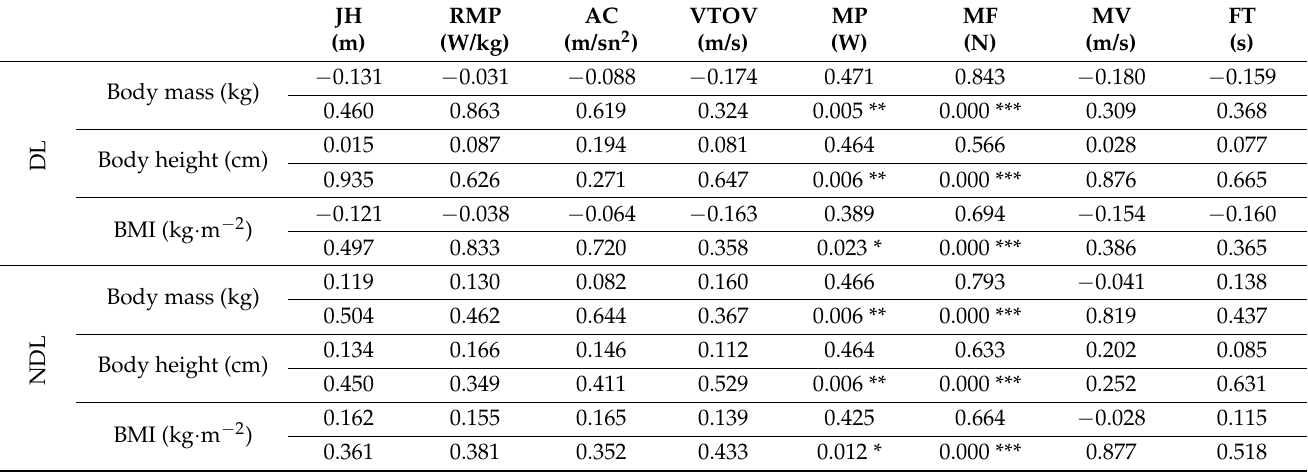
Table 3. Correlation coefficients between the single-leg CMJ and physical characteristics of the athletes for dominant and non-dominant